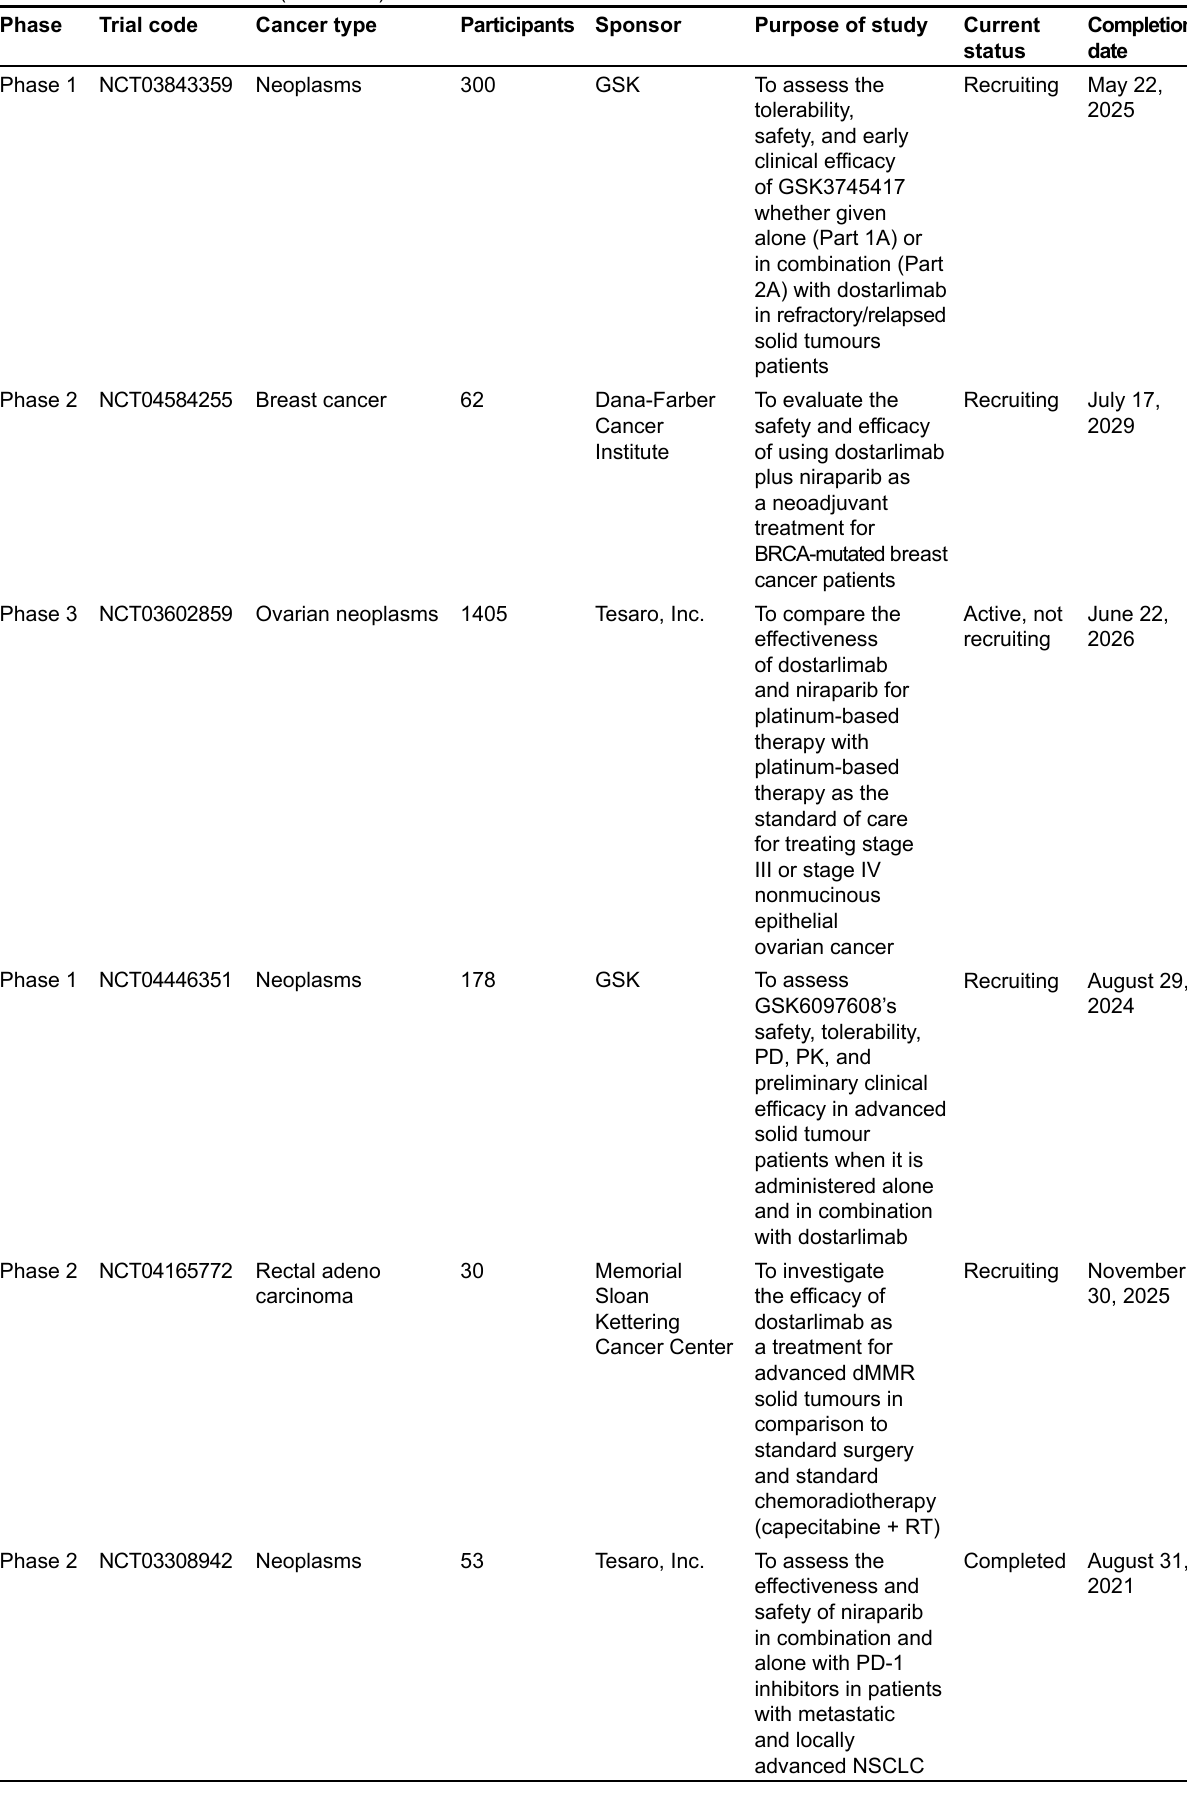
Table 2. Trials of dostarlimab ( continued